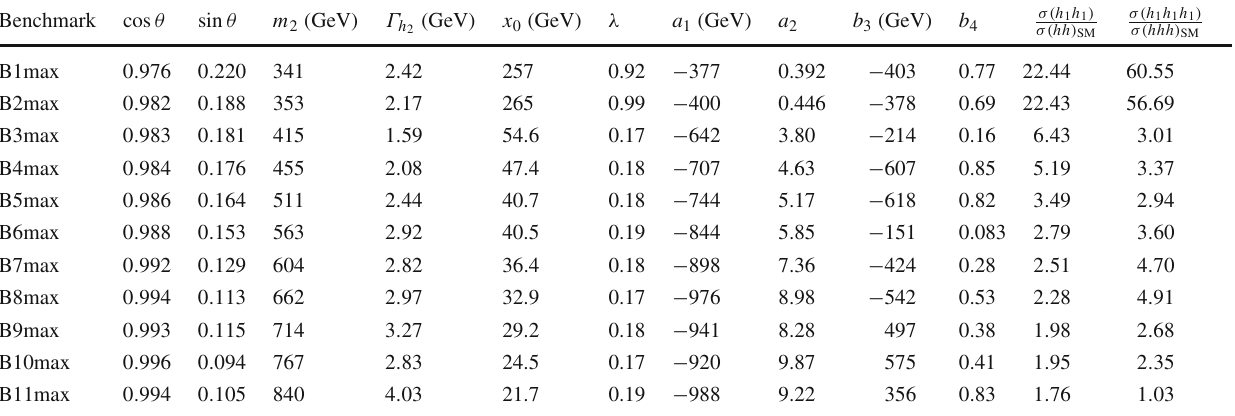
Table 5 Values of the various xSM independent and dependent param- eters for each of the benchmark values chosen to maximize the